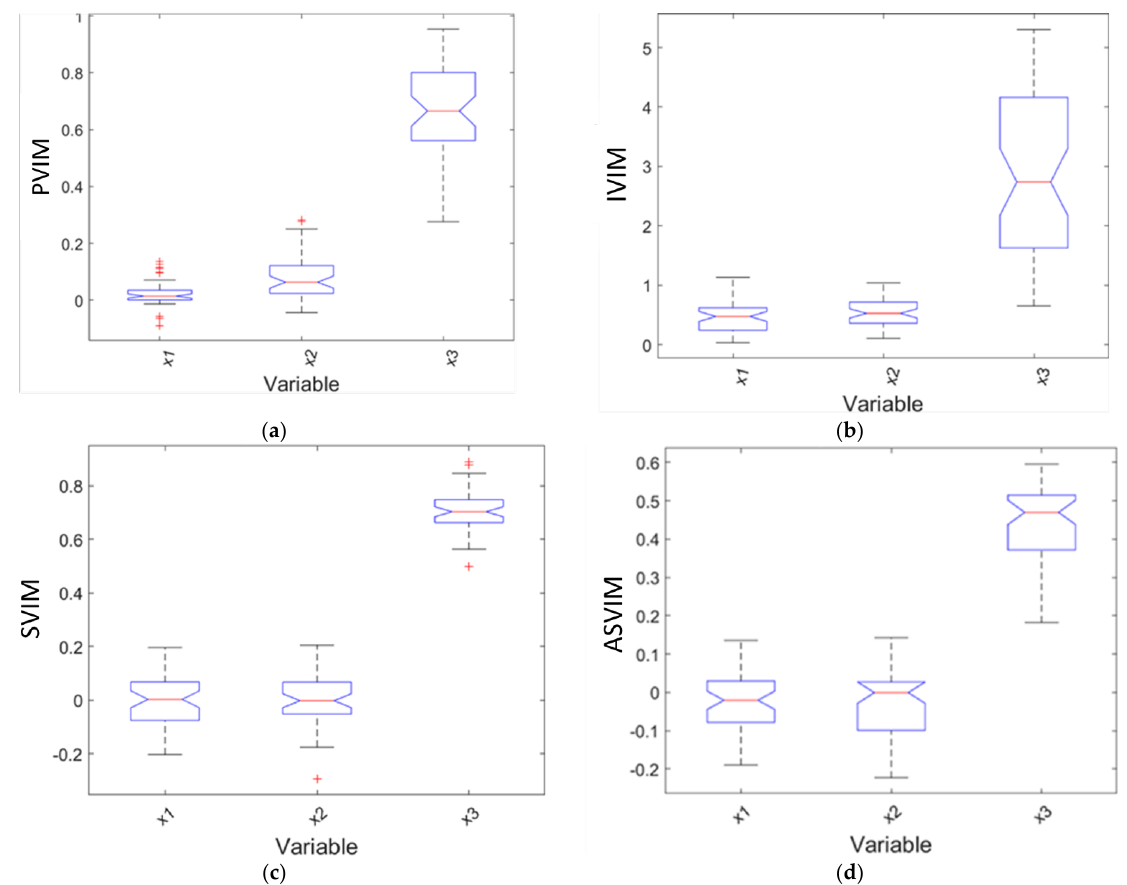
Figure 3. Relative importance of the correlated predictors in Case Study 1 based 50 runs, showing ( a ) permutation indices, MSE on OOB data, ( b ) impurity indices on OOB data, ( c ) Shapley value (R 2 ) on test data, and ( d ) approximate Shapley values (R 2 ) on test data.